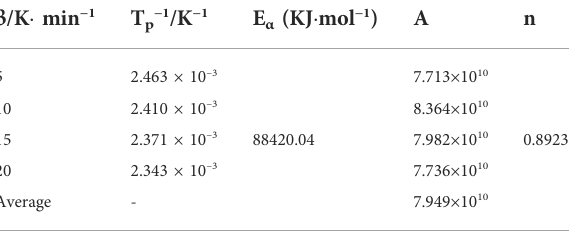
TABLE 1 Resin system kinetic parameters. TABLE 2 T i , T p , and T f Calculated with Different β .